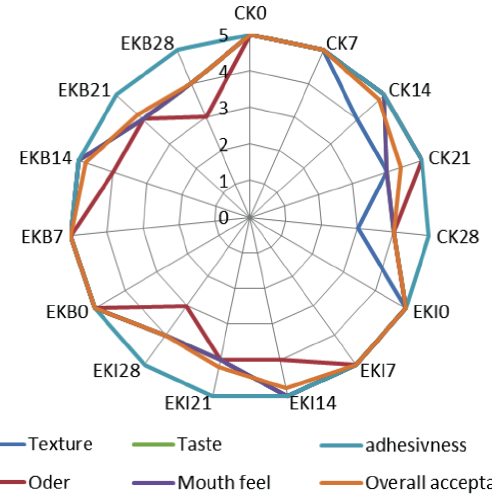
Figure 4 Effect of storage time (0 to 28 days) on sensory characteristics of kashk samples. CK: control kashk, EKI: experimental kashk with MIC (0.211 mg/mL of caper extract), and EKB: experimental kashk with MBC (0.350 mg/mL of caper